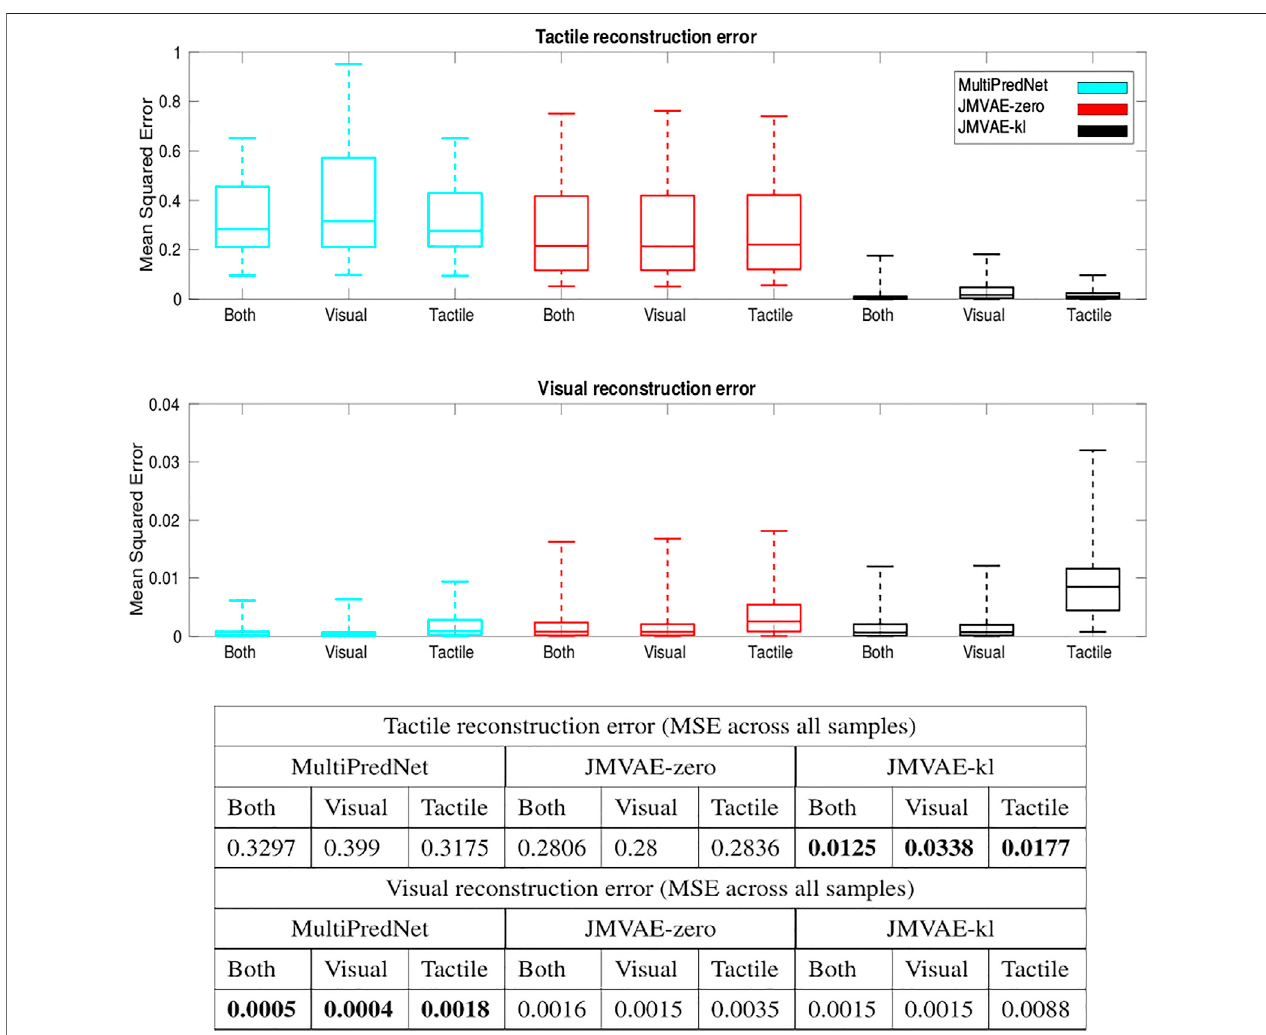
FIGURE8| Sensoryreconstructionerrorsfromthe3trainedmodelnetworksinresponsetoallfourconcatenatedtestsetsunder3testconditions; Both visualand tactilesensorydataavailable; Visual dataavailableandtactilemasked;and Tactile dataavailablewithvisualdatamasked.Thetoppanelboxplotssummarisestatisticsof the mean squared error between actual tactile sensory data and the reconstructed tactile impressions generated by each of the networks. The middle panel applied the sameanalysistothevisualreconstructionswiththeaverageMSEforeachmodelineachoftheconditionssummarisedinthetablebeneath(boldhighlightinglowest error